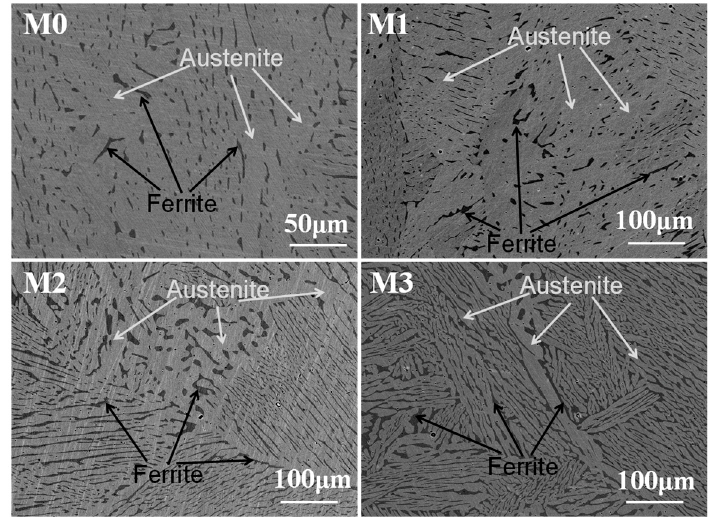
Figure 1. SEM images of the studied model alloys showing their duplex (austenite + ferrite) microstructures. (M0, M1, M2, and M3 corresponds the alloy with Mo content of 0.0, 0.20, 0.90, and 1.75 wt%, respectively.) Table 1. The ferrite content and compositions in the two phases of CDSS.